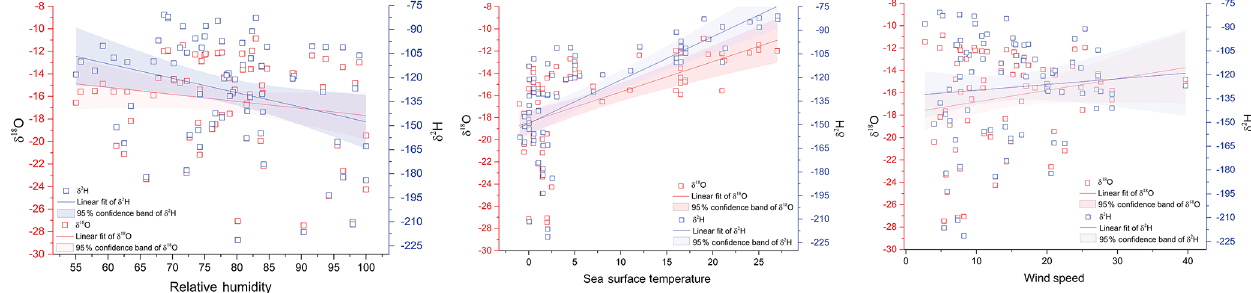
Figure 5. Linear regression for isotopic composition of water vapor and physical parameters (sea surface temperature, relative humidity and wind speed). Hollow red and blue squares represent the δ 18 O and δ 2 H, respectively, and the shaded areas depict the 95% confidence bands. The linear regression lines are shown as blue and red for δ 2 H and δ 18 O, respectively. The slope and intercept of the linear regression equations along with data from Uemura et al. (2008) are listed in Tables S1 and S2.